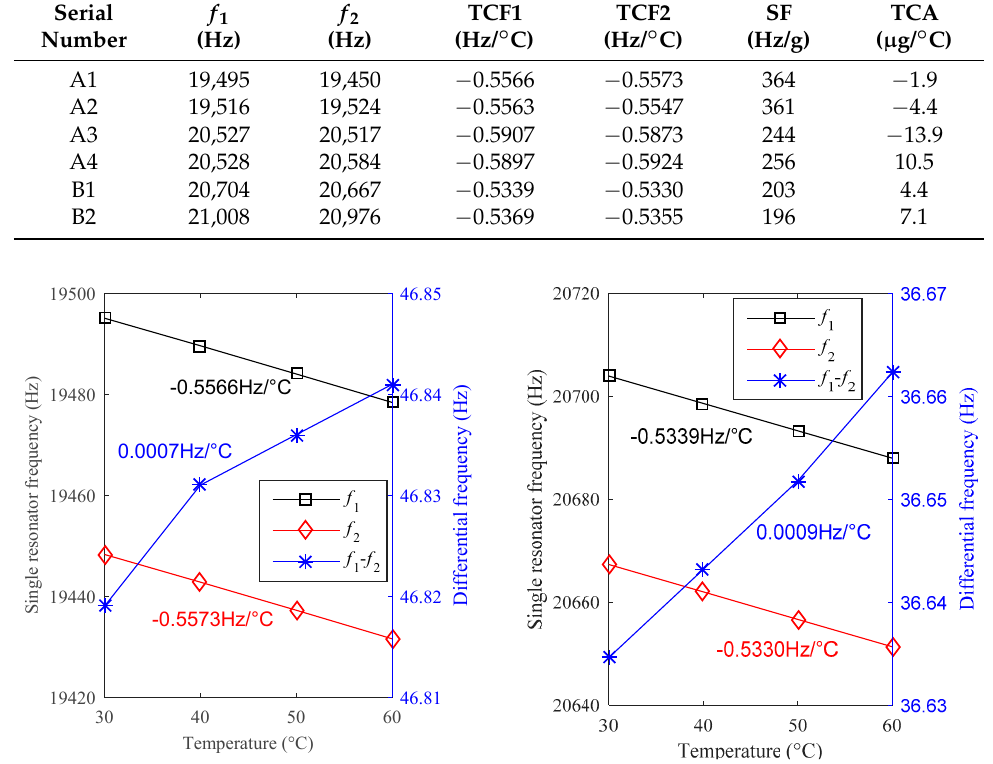
Table 1. Temperature drift of three types of MRA devices.